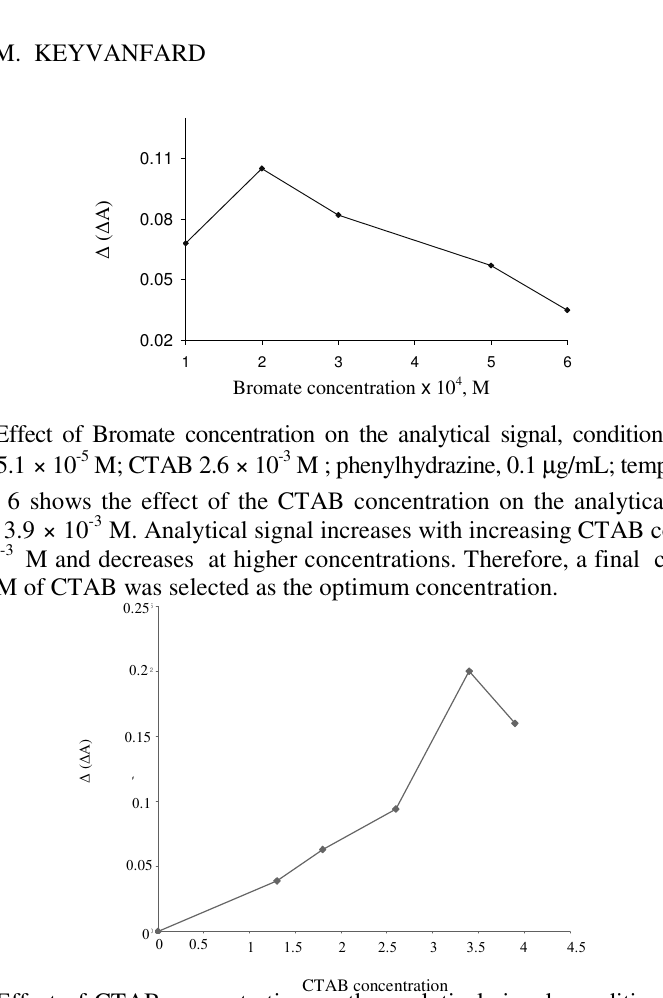
Figure 6. Effect of CTAB concentration on the analytical signal, conditions: HCl 0.06 M, - 2 × 10 -4 M ;phenylhydrazine, 0.1 µ g/mL; temperature 27 methyl red 5.1 × 10 -5 M; BrO 3